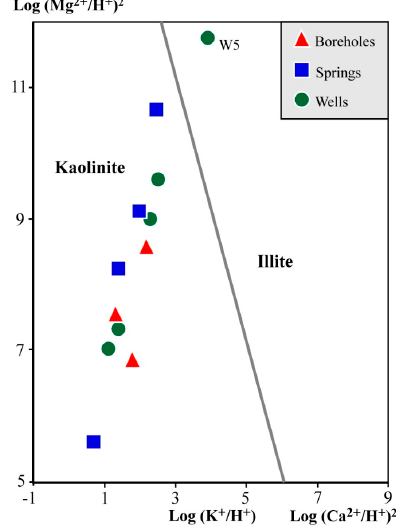
Figure 5. Plots of various water sources in the Korjinski [43] diagram.